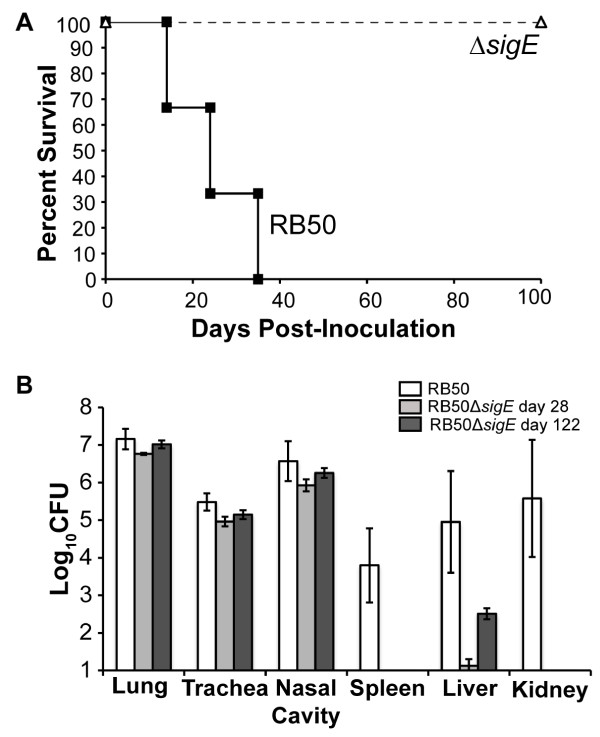
Survival and systemic colonization of Rag1−/−mice following infection with RB50 and RB50ΔsigE. (A) Groups of Rag1−/− mice (n = 6) were inoculated with 5 × 105 CFU of RB50 (solid line with filled squares) or RB50ΔsigE (dashed line with open triangles) and monitored for survival. (B) Groups of four Rag1−/− mice were inoculated with 5 × 105 CFU of RB50 (white bars) or RB50ΔsigE (light grey bars) and dissected on day 28 post-inoculation for bacterial enumeration in the indicated organs. In a separate experiment, Rag1−/− mice inoculated with RB50ΔsigE were euthanized for bacterial numbers in the indicated organs on day 122 post-inoculation (dark grey bars). The bacterial load is expressed as log10 CFU ± SE. Limit of detection is indicated as the bottom of the y-axis.